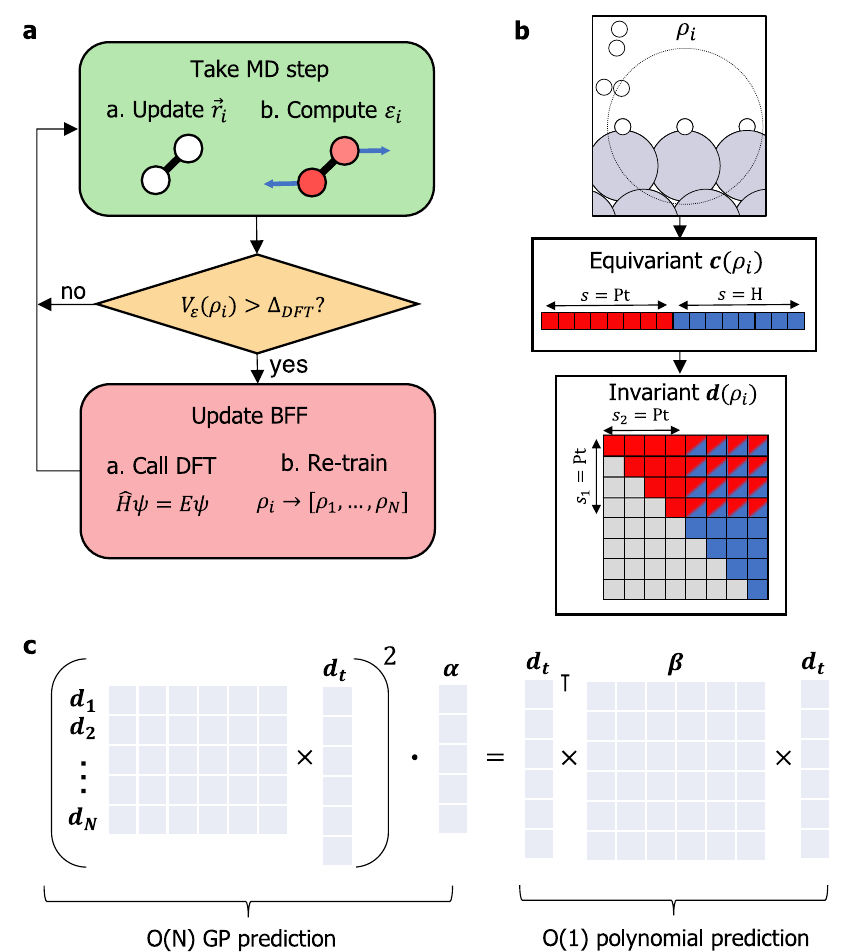
Fig. 1 | On-the- fl y training and acceleration of many-body Bayesian force fi elds (BFF).a Ateachtime-stepoftheMDsimulation,localenergies,forces,andstresses arecomputed with theSGPmodel.If the uncertaintyonalocalenergy exceedsthe chosen threshold Δ DFT , a DFT calculation is performed and the model is updated. b Mapping of local environments ρ i onto multielement descriptors derived from theatomicclusterexpansion.Theenvironmentis fi rstmappedontoanequivariant